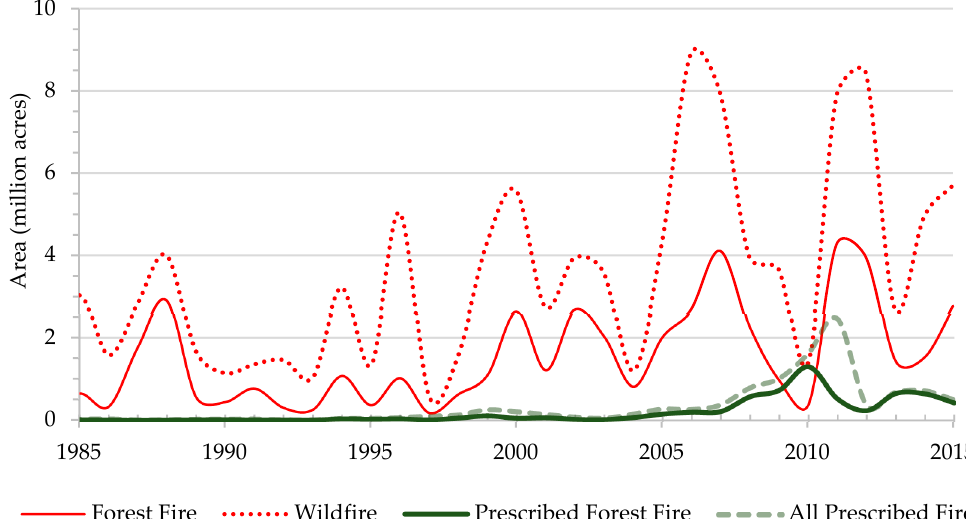
Figure 1. Historical trend of fire in the continental United States. Data from MTBS[3].